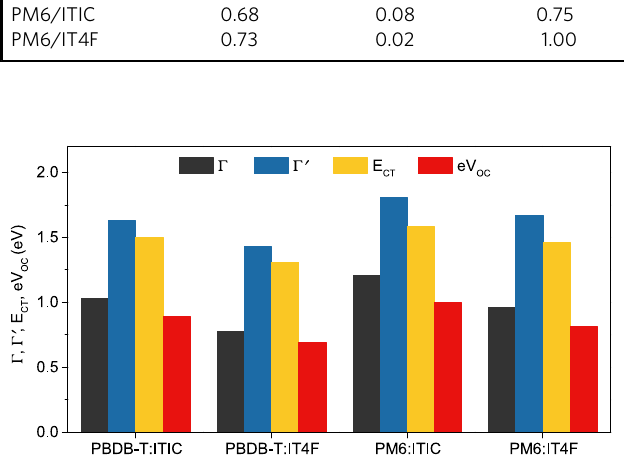
Fig. 4 Vacuum level shift enhances the energy of interfacial states. Comparison of the charge-transfer state energy (E CT ) and open-circuit voltage (V OC ) values measured in devices with the photovoltaic gaps Γ ( Γ ′ ) before (after) VL shift